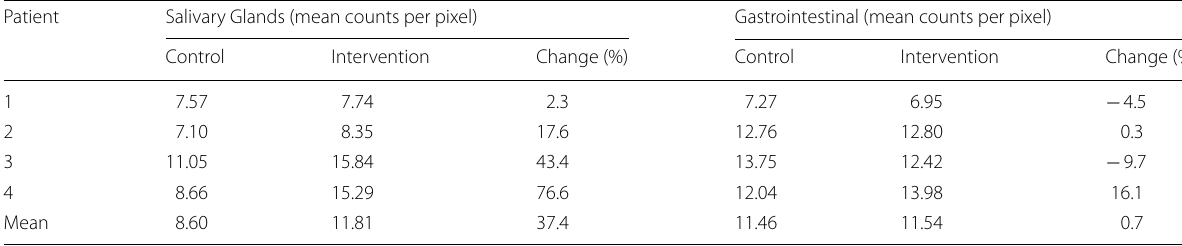
Table 4 Uptake of 123 I without and with premedication with GPB Patient Salivary Glands (mean counts per